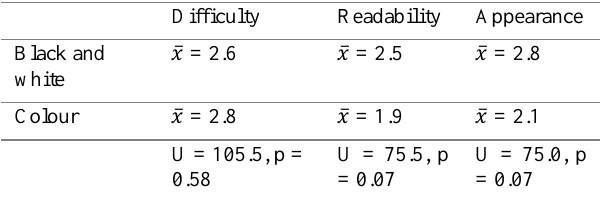
Subjective analysis results for second code snippet